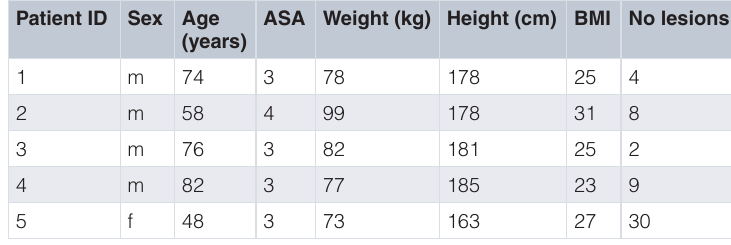
Table 1. Patient demographics, medical status and extent of surgery.